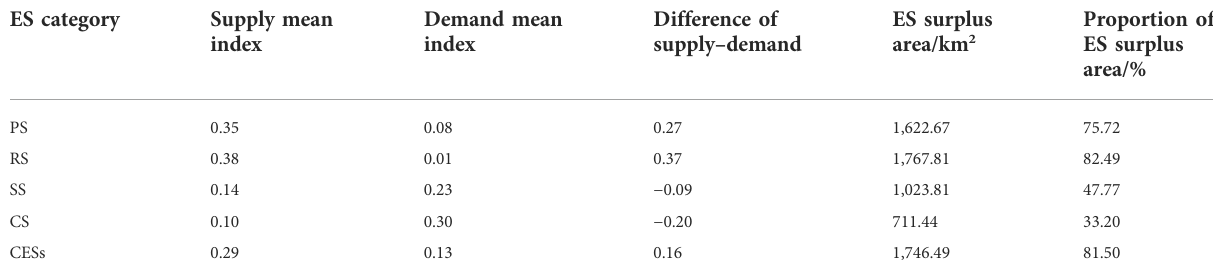
TABLE 5 Comparison of ES supply – demand in the study